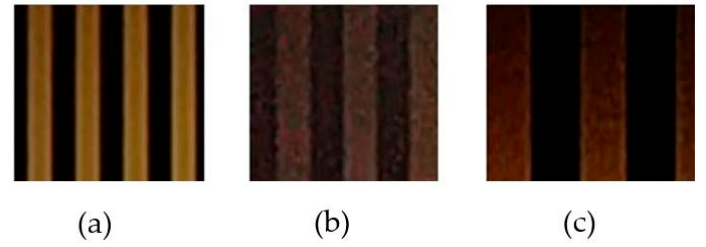
Figure 7. OCC frequency band.